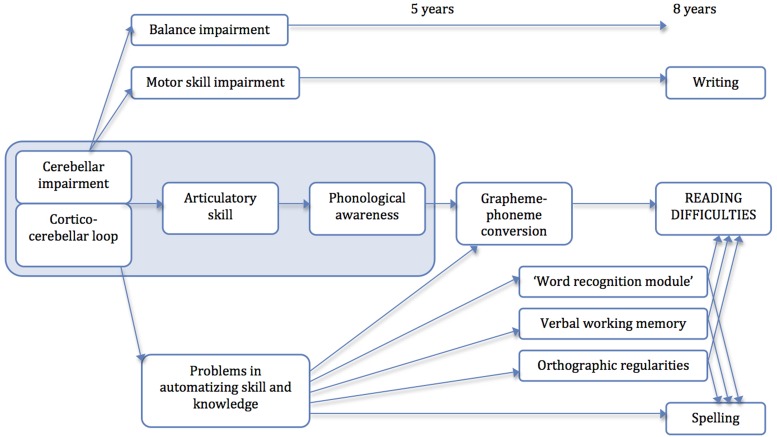
A causal chain of the cerebellar-deficit-hypothesis (cf. Nicolson and Fawcett, 2011).